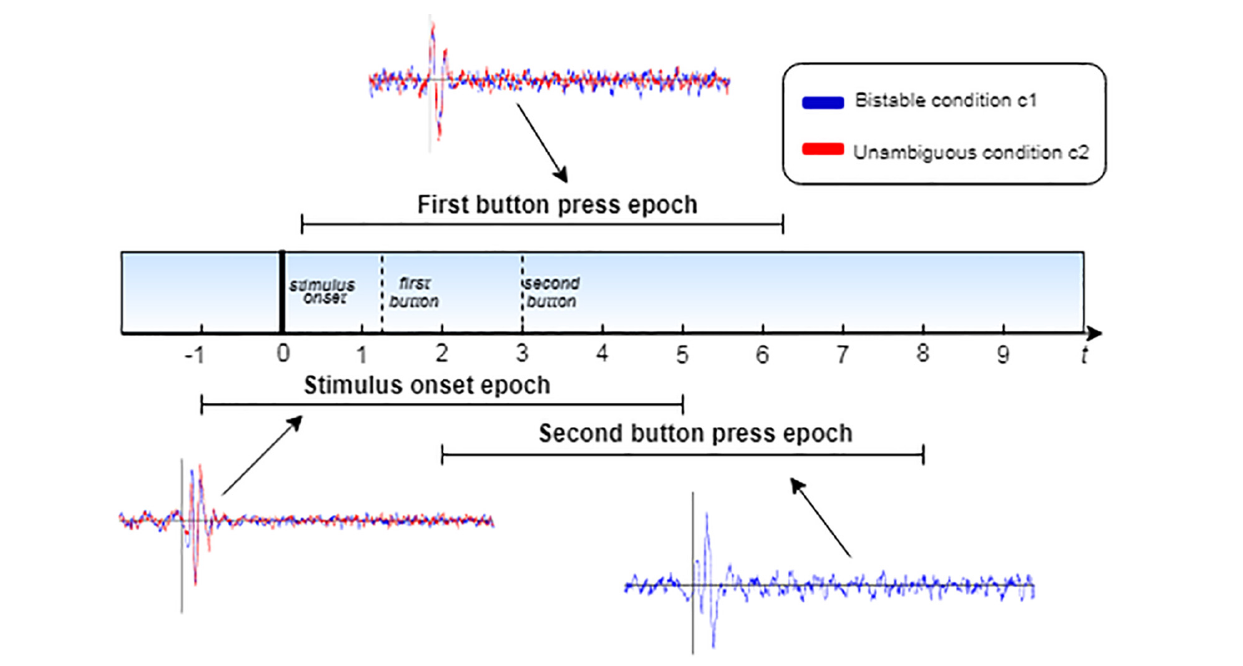
FIGURE 3 | Schematic diagram of the epoch extraction process. The plots correspond to the ERPs, as calculated for each epoch, where the blue line corresponds to the bistable condition c1 and the red line to unambiguous condition c2.